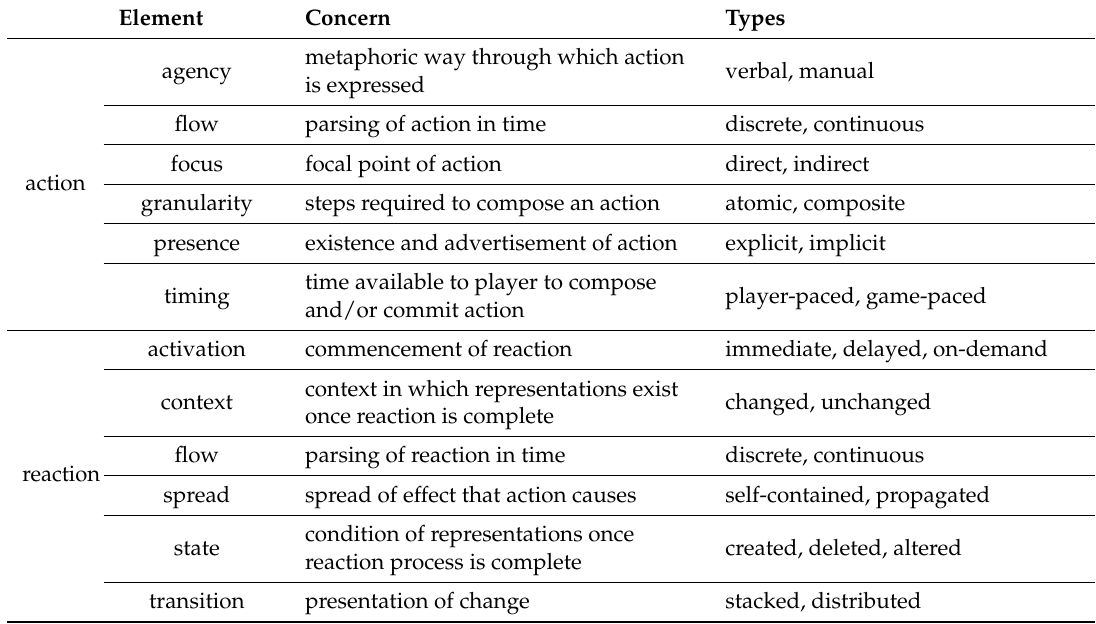
Table 2. Summary of player–game Interaction Elements in the INFORM